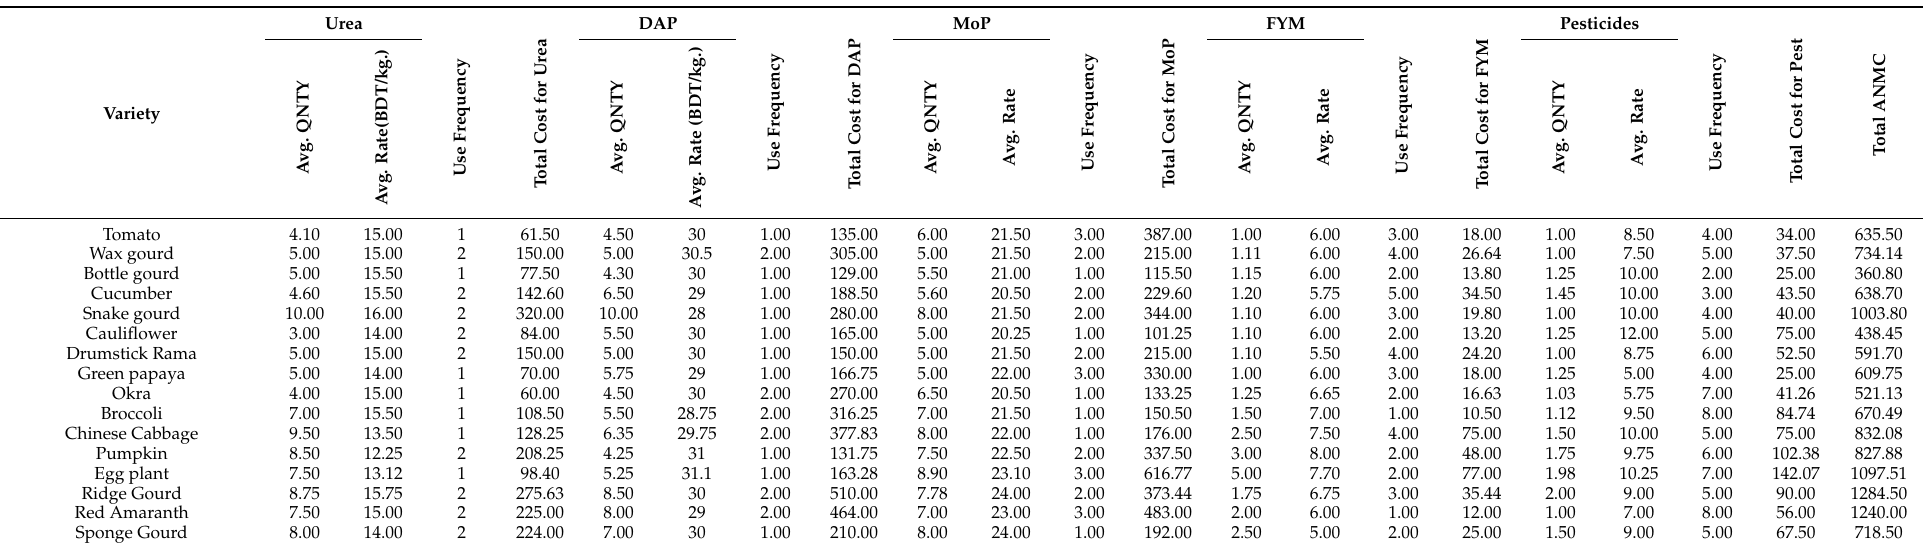
Table 3. Average manpower costs for nursery management